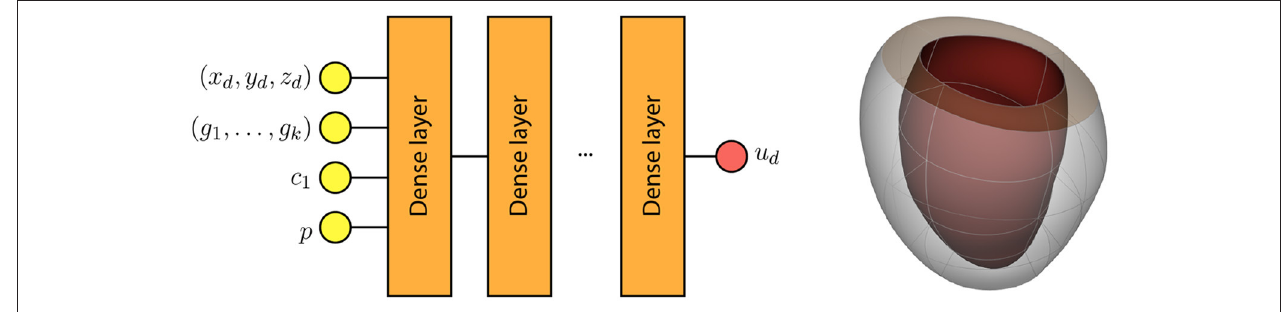
FIGURE 1 | (left) AI-surrogate depicting its inputs and outputs (Maso Talou et al., 2020); (right) Example of the geometry of the ventricle at diastasis for g = 0 .